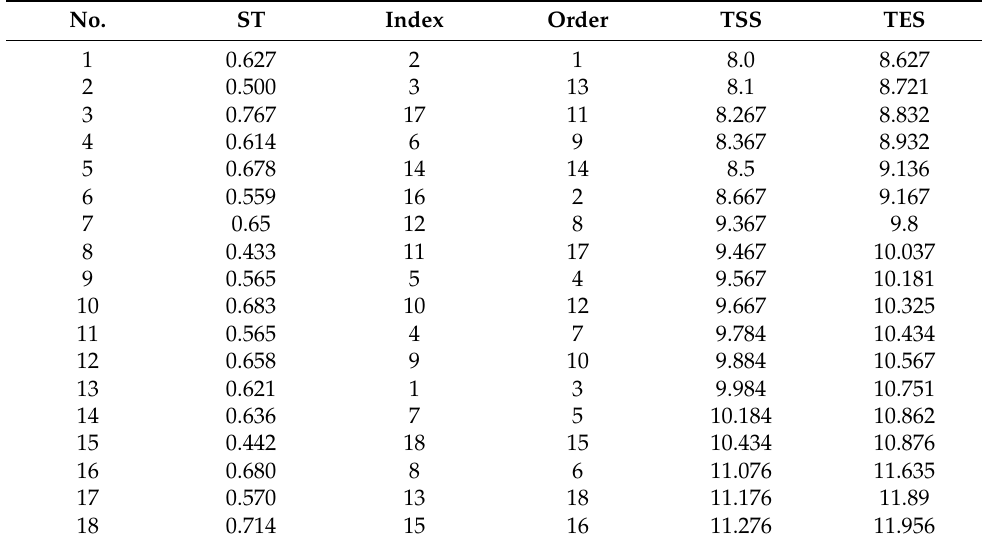
Table 11. Optimal results of 18 vessel experiment using GA.